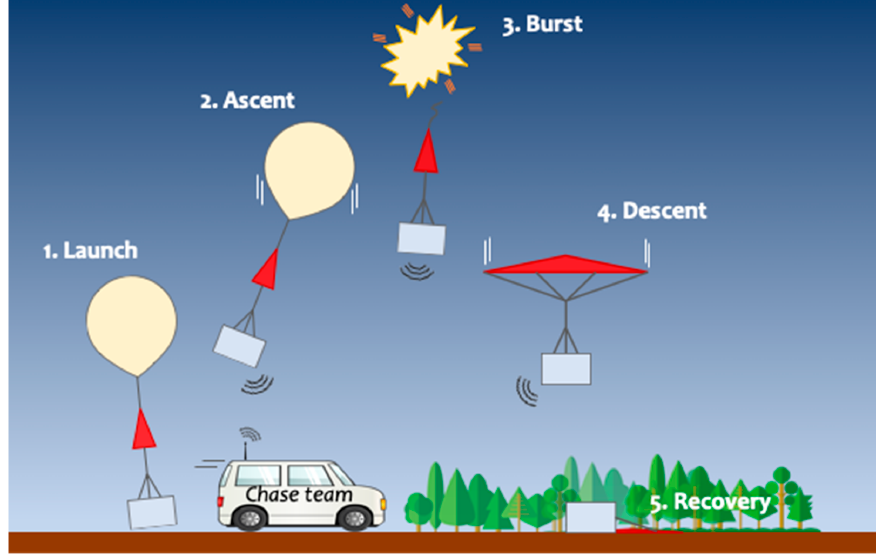
Figure 8. Mission operation